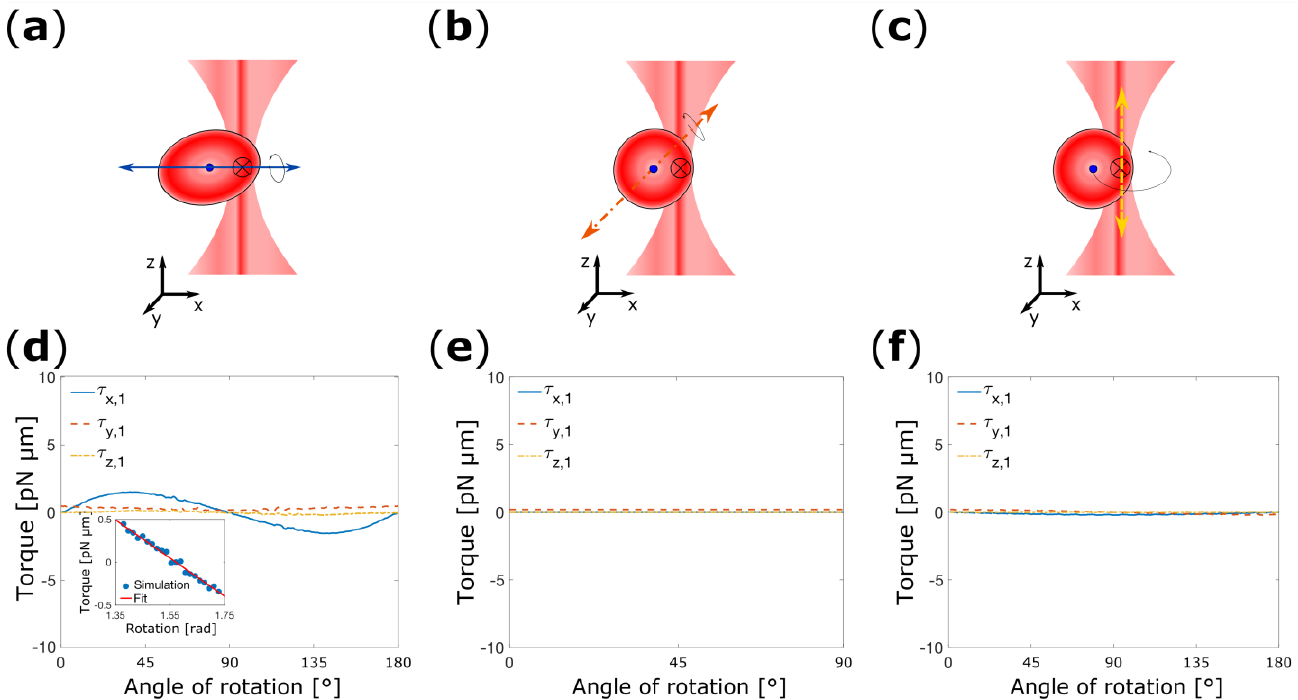
Figure 3. ( a ) Schematic depiction of cell rotation around an axis passing through the center of mass of the RBC and parallel to the x -axis. ( b ) Schematic depiction for cell rotation around the y -axis. ( c ) Schematic representation of the cell’s rotation around the z -axis. The black arrows indicate the direction of rotation. Torque-rotation plot for rotation around x ( d ), y ( e ), and z ( f ). The insert shows the fitting of the optical torques to obtain the rotational tapping stiffness.